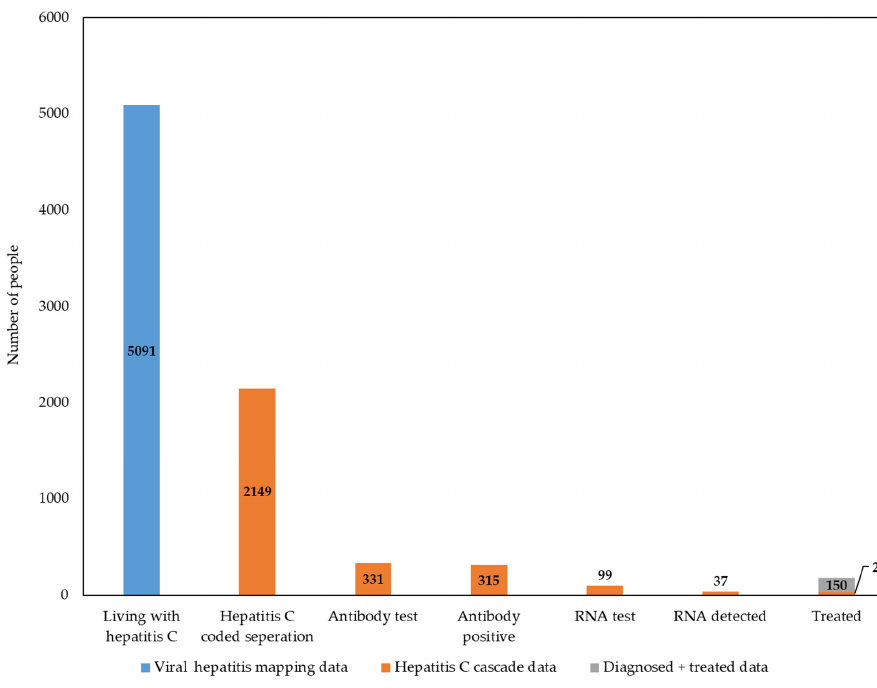
Figure 1. Hepatitis C care cascade for patients with a hepatitis C coded episode at the Alfred Hospital from 2016 to 2019. Viral Hepatitis Mapping Project, National Report 2020 data [5] were used to estimate the number of people living with hepatitis C in the hospitals catchment area (blue). The care cascade determined using the hospitals datasets (admissions, pathology, and pharmacy) is shown in orange. The orange portion of the treated column shows patients who also had an antibody- and/or RNA-positive test, while the grey portion shows patients with a hepatitis C coded separation and evidence of treatment.